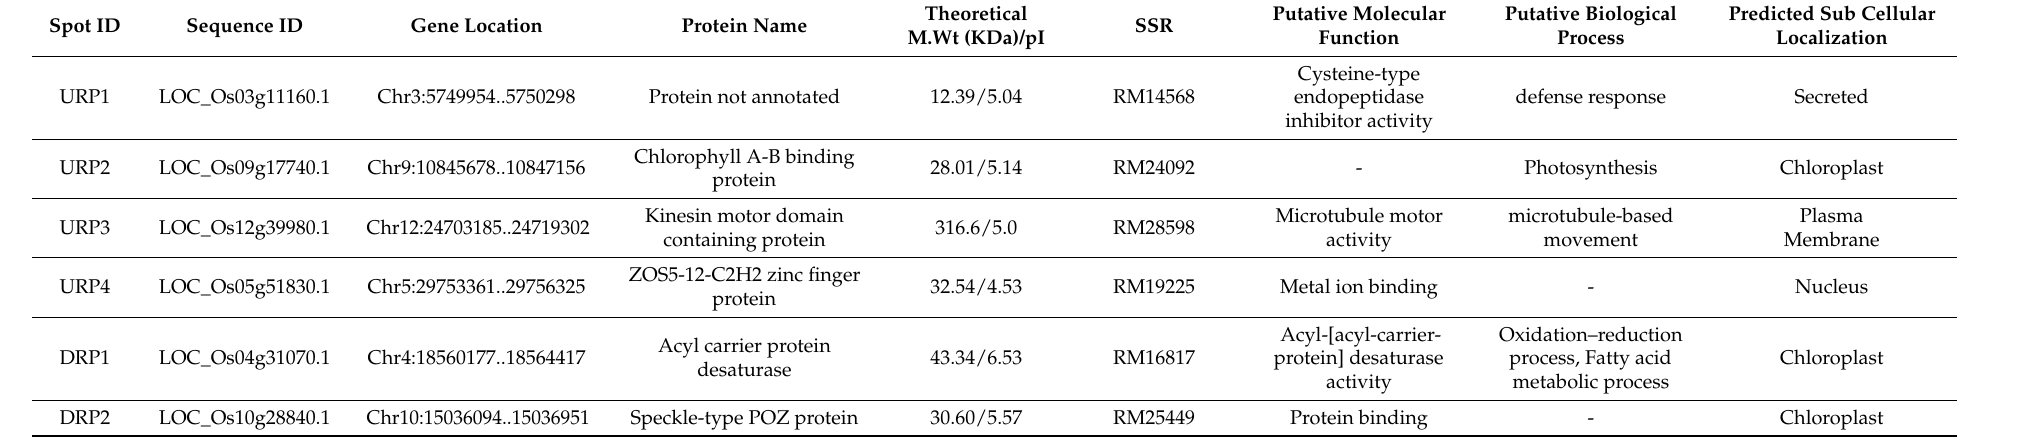
Table 2. List of proteins identified by MALDI-TOF-MS/MS analysis of wild rice accession O. grandiglumis in response to R. solani inoculation.